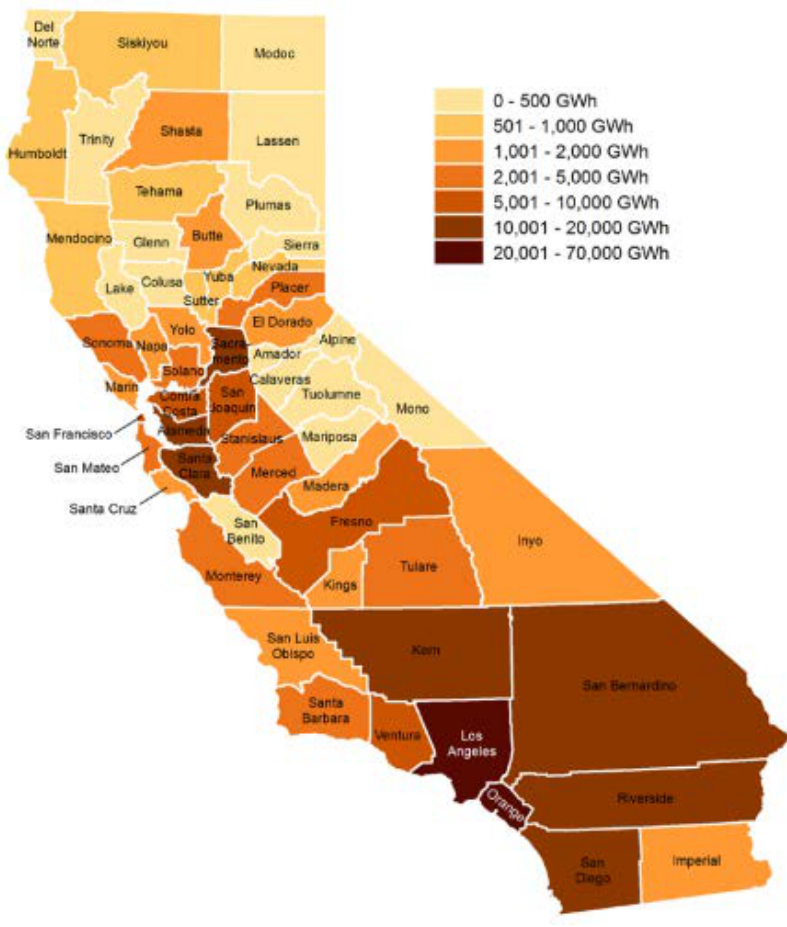
Figure 1. Electricity consumption in California for 2017 (residential and non-residential sectors) by county. Source: California Energy Commission (CEC, 2018) staff. http://ecdms.energy.ca.gov/.